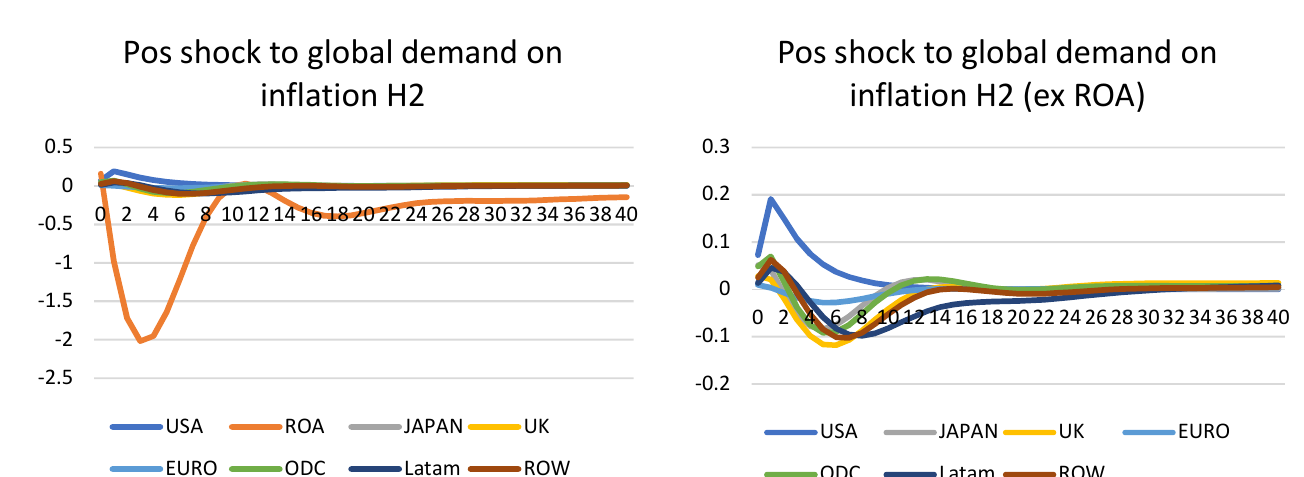
Figure 4. Positive global demand on inflation.